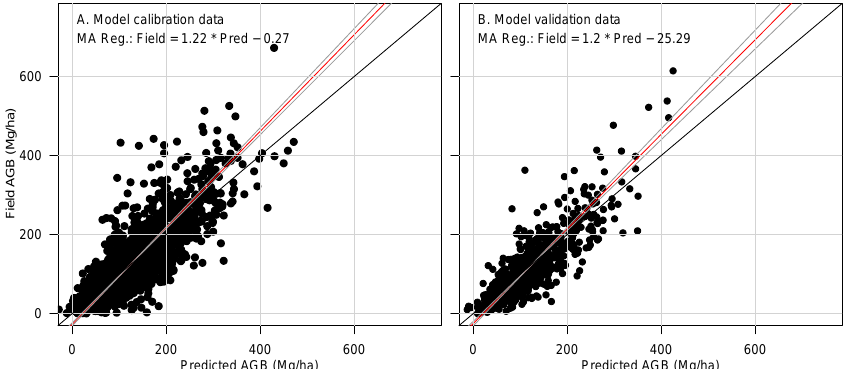
Figure 6. Scatter plot and major axis regression trend line of field-measured AGB versus predicted values from the raw AGB trimmed median probability linear regression model (Table 6). Plots include data from: ( A ) all model calibration data, ( B ) all validation data from the model construction data set. Red dashed line is linear fit from the major axis regression of field-measured AGB versus predicted values on the independent validation data subset. Grey lines are 95% confidence intervals from 1000 permutations. Black line is